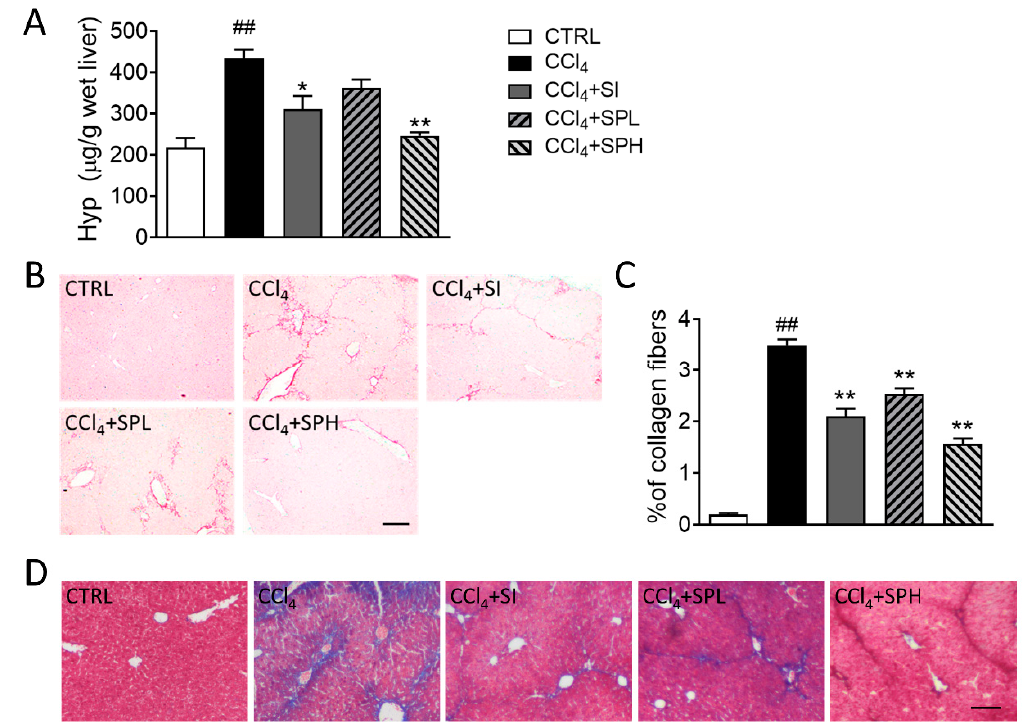
Figure 4. Effects of spore powder of A. camphorata on collagen accumulation in the liver tissues in CCl 4 -treated mice. ( A ) Hydroxyproline content (Hyp) in liver tissues from mice of different groups. ( B ) Sirius red staining and collagen content ( C ) in liver tissues from mice of different groups. Masson Trichrome staining ( D ) in liver tissues from mice of different groups. Data are presented as mean ± SEM (n = 6). Different letters indicate significantly different values according to a one-way ANOVA using Tukey’s test for multiple comparisons. Compared with control group (CTRL), ## p < 0.01; compared with CCl 4 -induced group (CCl 4 ), * p < 0.05, ** p < 0.01. Scale bar: 100 μ m. Hyp, hydroxyproline; CCl 4 , carbon tetrachloride; SI, silymarin; SPL, low-dose treatment with spore powder of A. camphorata ; SPH, low-dose treatment with spore powder of A. camphorata .